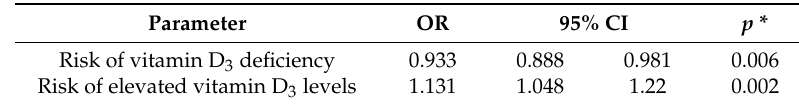
Table 5. The influence of age on the risk of vitamin D 3 deficiency and the risk of elevated vitamin D 3 levels. Parameter OR 95% CI p * Risk of vitamin D 3 deficiency 0.933 0.888 0.981 0.006 Risk of elevated vitamin D 3 levels 1.131 0.002